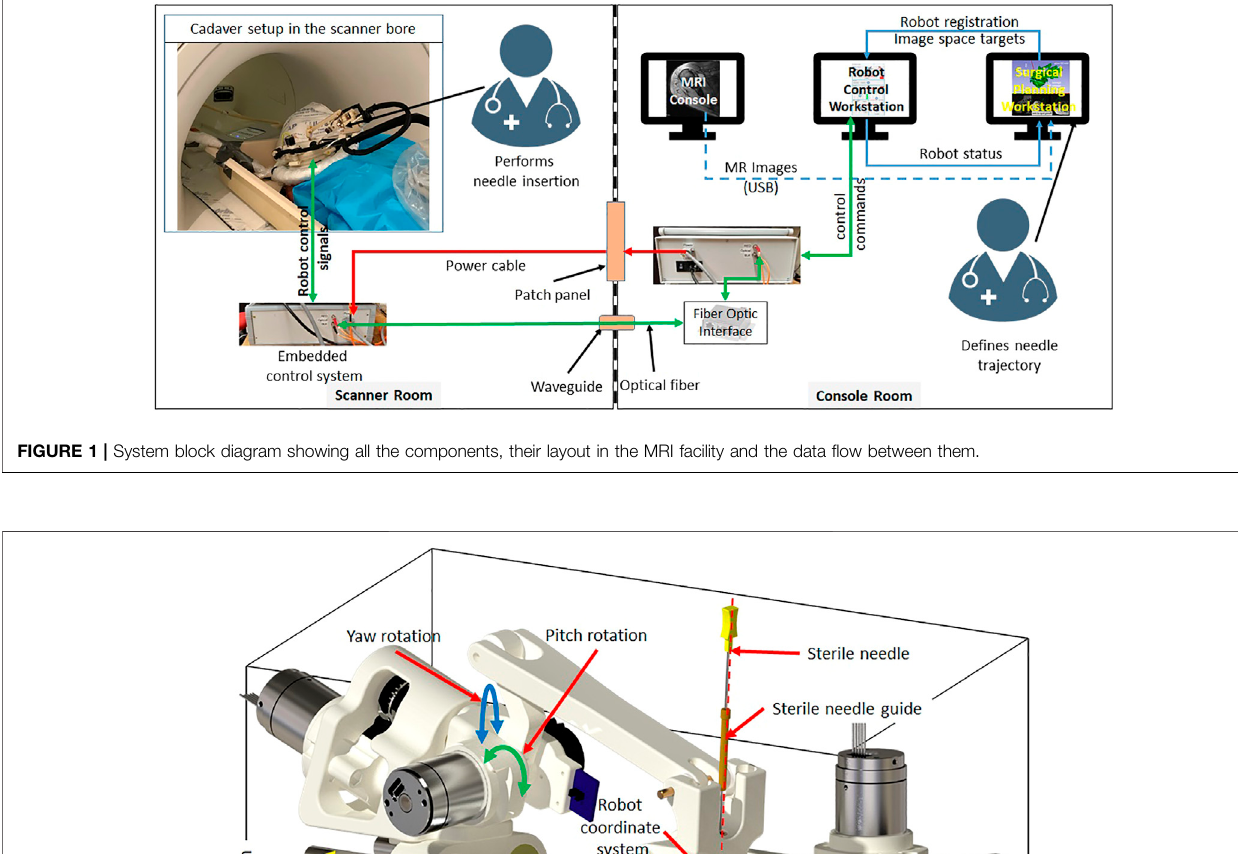
Frontiers in Robotics and AI |